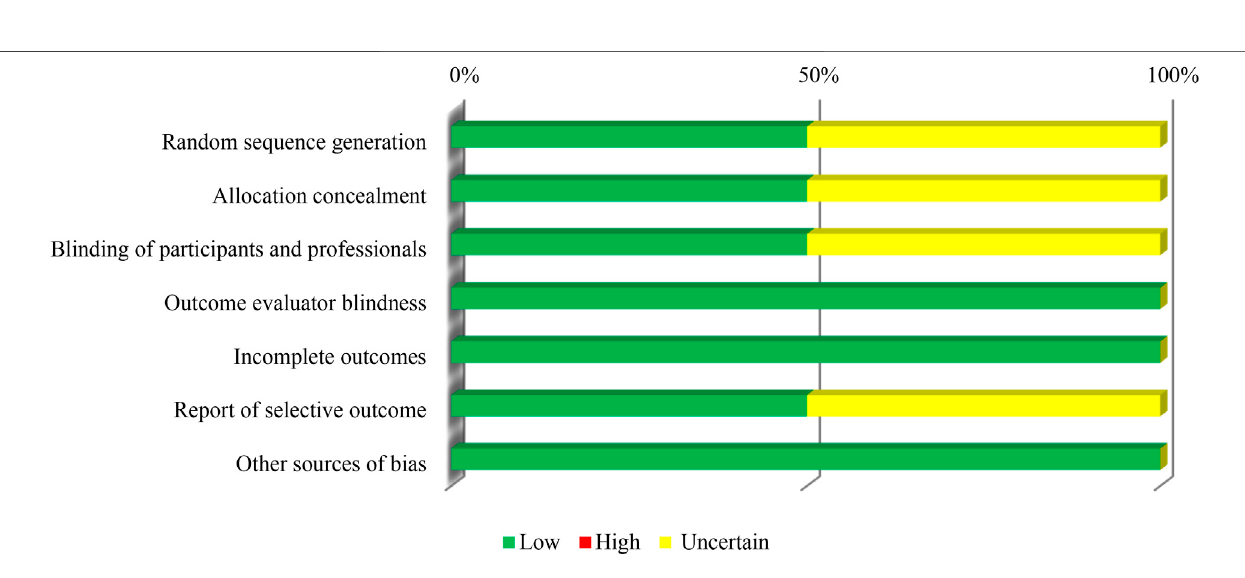
FIGURE 3 | Methodological quality of clinical trials